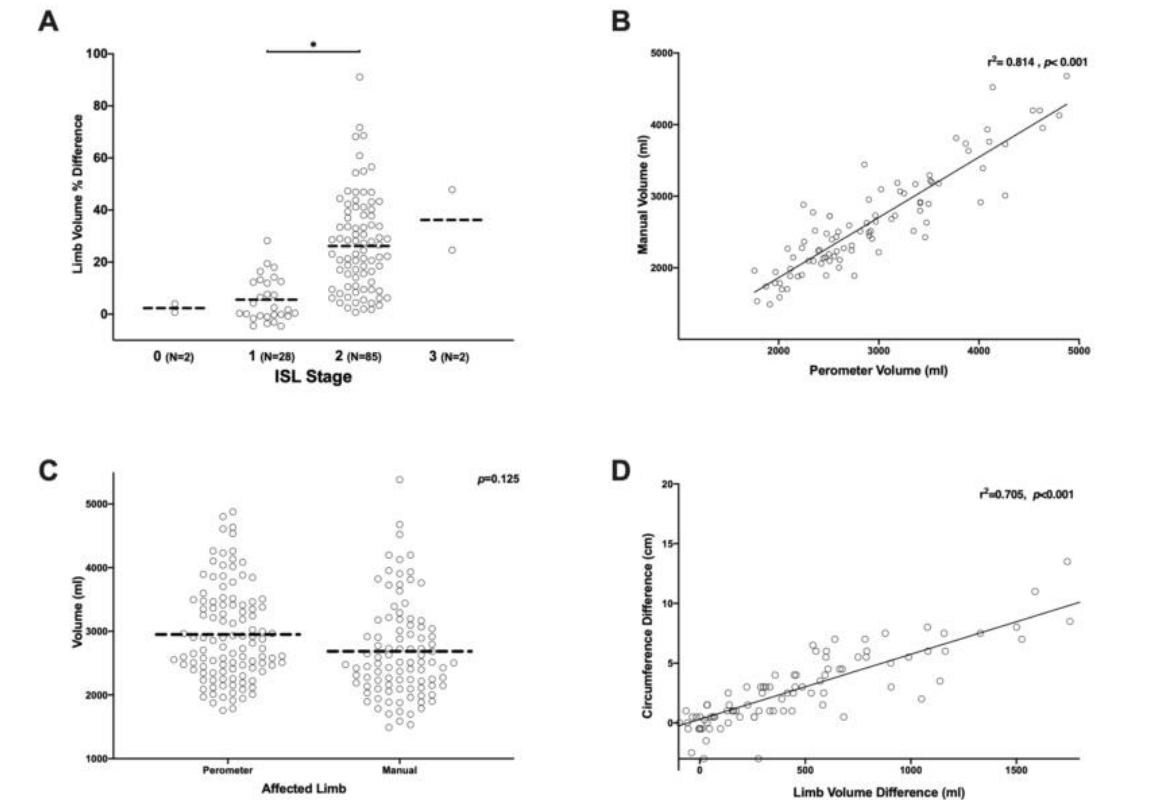
Table 2. Specificity and sensitivity of assessments for diagnosis of lymphedema (volume difference >10%).